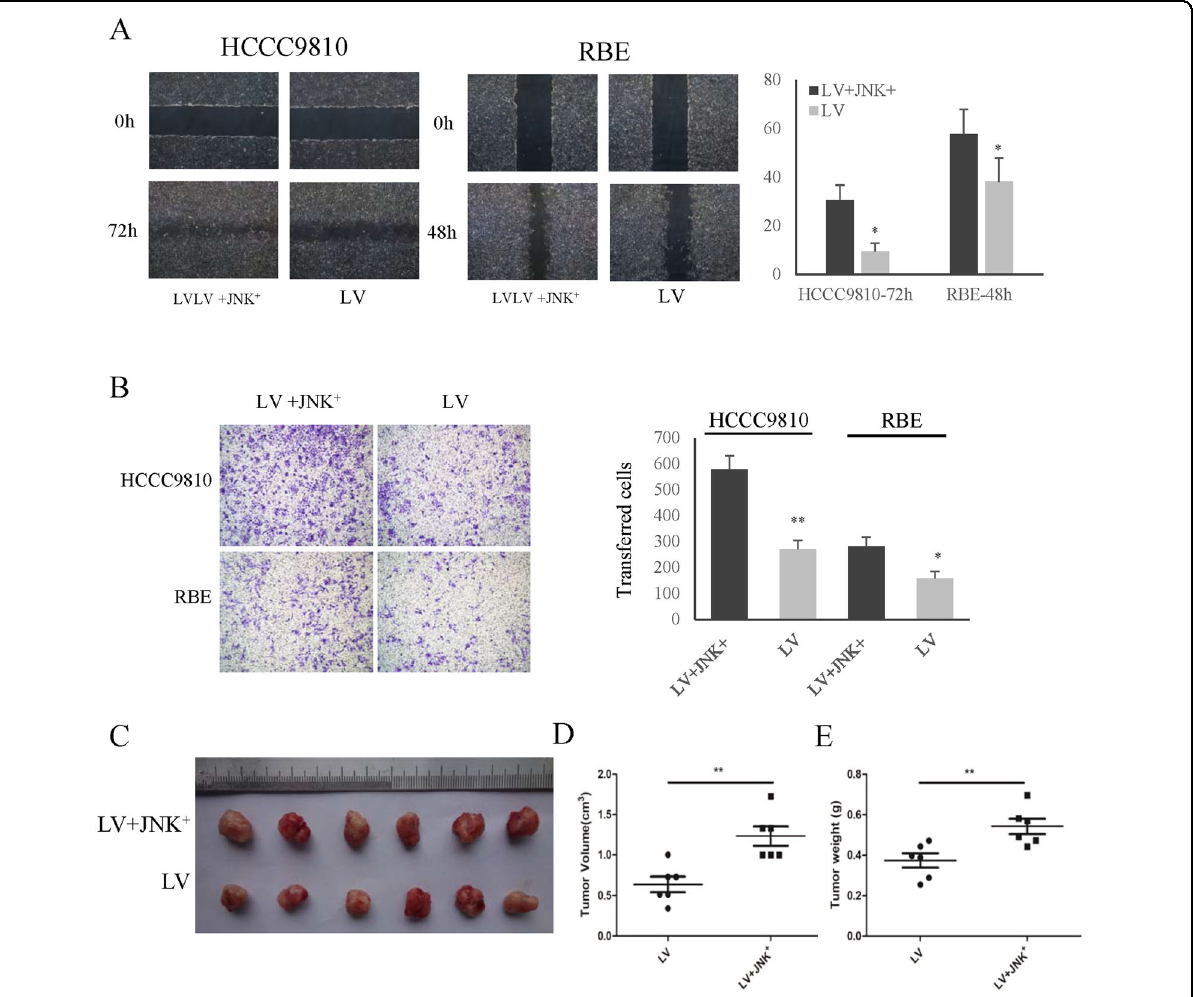
Fig. 6 BUB1B regulated invasiveness of CAA cells in a JNK-c-Jun-dependent manner. A The ability of CCA cell invasiveness was enhanced after activation of JNK-c-Jun through wound healing. B Transwell assays showed that the activation of JNK-c-Jun promoted the CCA cell migration. C – E A subcutaneous xenograft tumor model in nude mice to determine the effect of BUB1B on tumorigenicity. The activation of JNK-c-Jun promoted tumorigenicity compared to the control group ( N = 6) (* p < 0.05; ** p <